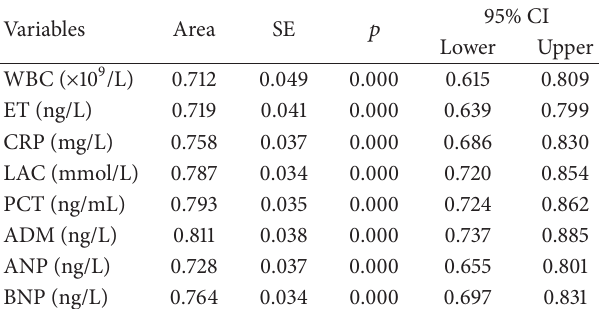
Table 5: The AUCs of WBC, ET, CRP, LAC, PCT, ADM, ANP, and